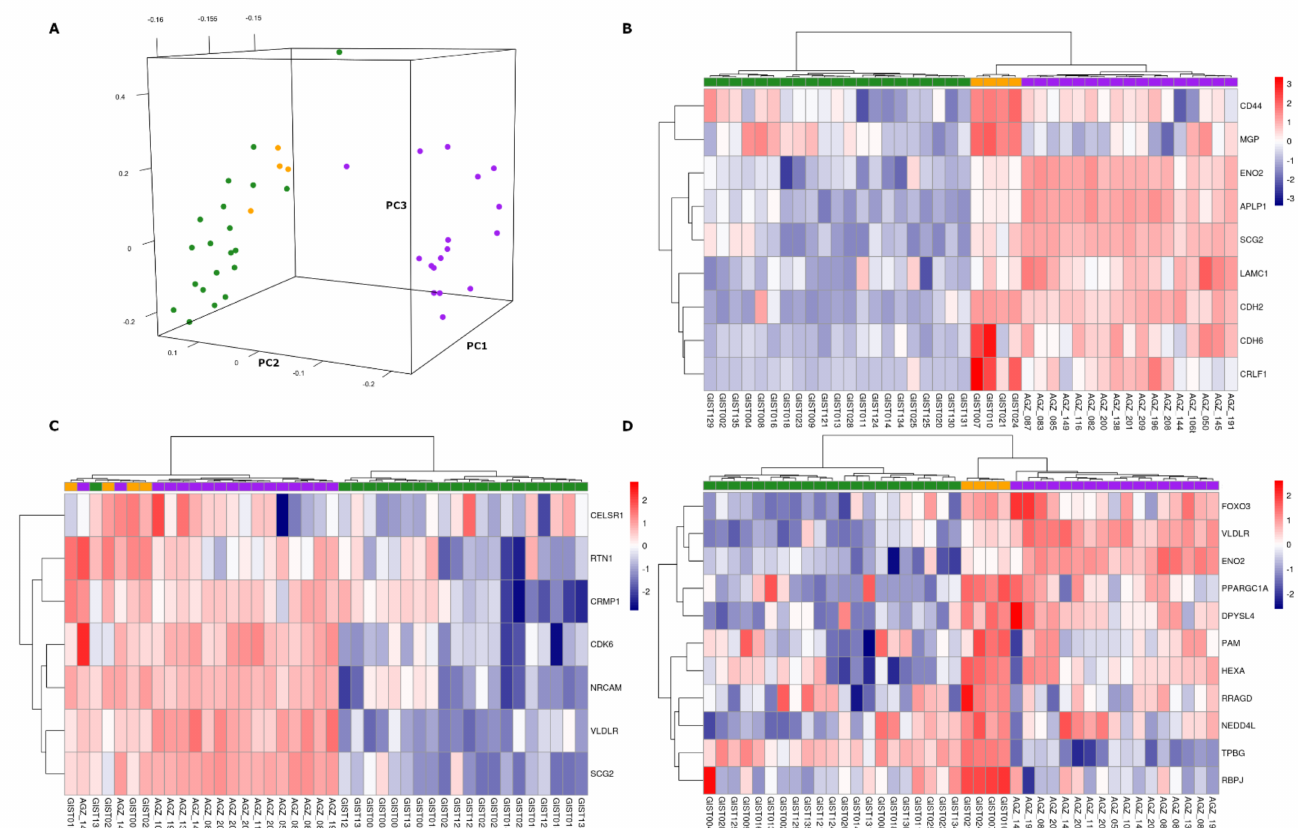
Figure 3. Comparative analysis between GISTs analyzed with microarray (number of SDH-deficient GISTs = 4; number of KIT-mutant GISTs = 21) and pheochromocytoma/paraganglioma carrying succinate dehydrogenase complex subunit B (SDHB) mutations. PCA highlights that GISTs (both SDH-deficient and KIT-mutant) cluster separately from pheochromocy- toma/paraganglioma ( A ). Hierarchical clustering for the sets of genes emerged by enrichment analysis for the signaling of epithelial-to-mesenchymal transition (EMT) ( B ), hedgehog pathway ( C ), and hypoxia ( D ). Color labels orange, green, and purple correspond respectively to SDH-deficient GISTs, KIT-mutant GISTs, and pheochromocytoma/paraganglioma